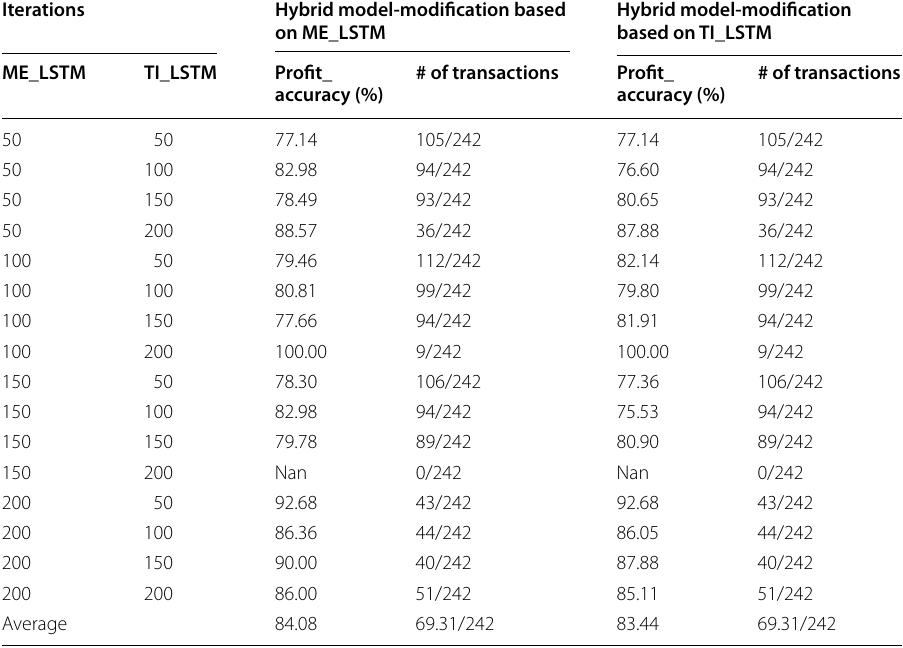
Table 15 Hybrid model: five‑days‑ahead predictions Iterations Hybrid model‑modification based on ME_LSTM